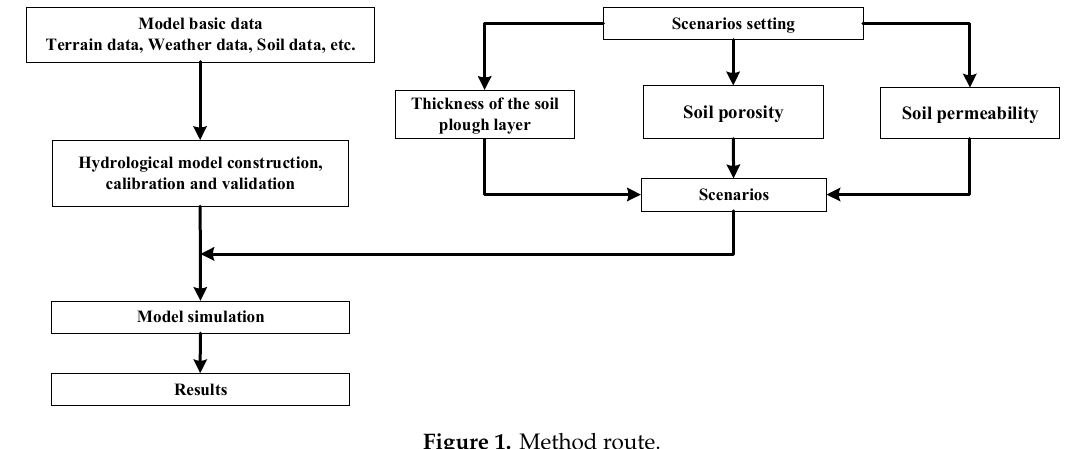
Figure 1. Method route.